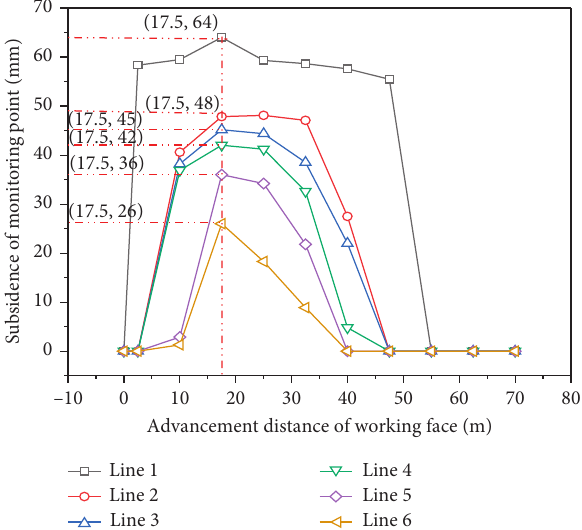
Figure 11: Subsidence of monitoring points.